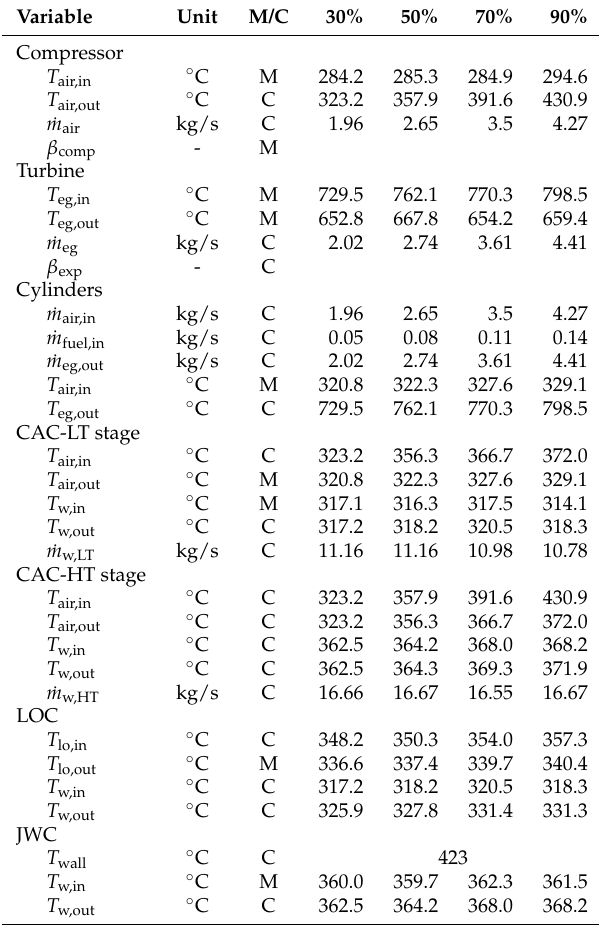
Table A2. Auxiliary engines, measured and calculated temperatures and flows at different engine loads.